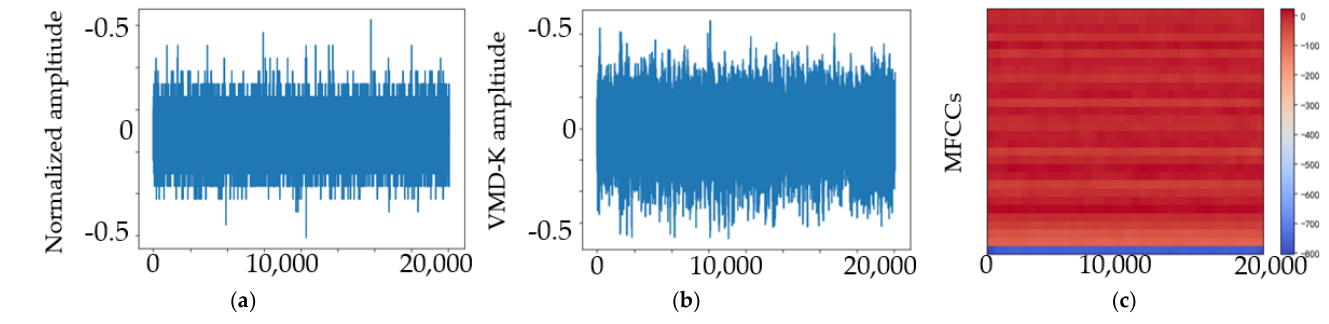
Figure 9. AE signals of the OR damage state at 20 rpm and 100 kN radial load: ( a ) original signal; ( b ) signal after denoising; ( c ) MFCCs.